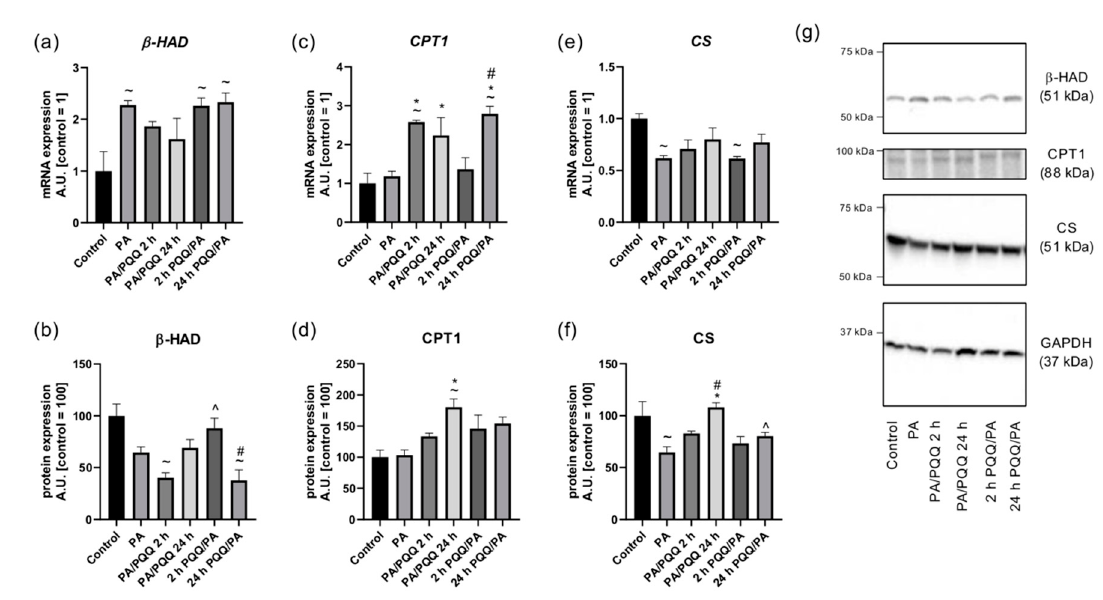
Figure 6. Effects of short- and long-time incubation with PQQ on the mRNA and protein levels of ( a,b ) 3-hydroxyacyl-CoA dehydrogenase, ( c,d ) carnitine palmitoyltransferase I, and ( e,f ) citrate synthase in L6 myotubes. ( g ) Representative Western Blot data. The control is set as 1 (mRNA) or 100 (protein). The values are presented as mean ± SEM and are based on six independent determinations. ANOVA with a post hoc Tukey’s test was applied. ~ p < 0.05, study groups versus control; * p < 0.05, PQQ-incubated groups versus palmitate group; # p < 0.05, time-dependent differences (long- vs. short-time incubation with PQQ); ^ p < 0.05, sequence-dependent differences (pre-incubation with PQQ vs. post-incubation with PQQ). ANOVA: analysis of variance; GAPDH: glyceraldehyde 3-phosphate, mRNA: messenger RNA; PA: palmitic acid; PQQ: pyrroloquinoline quinone.